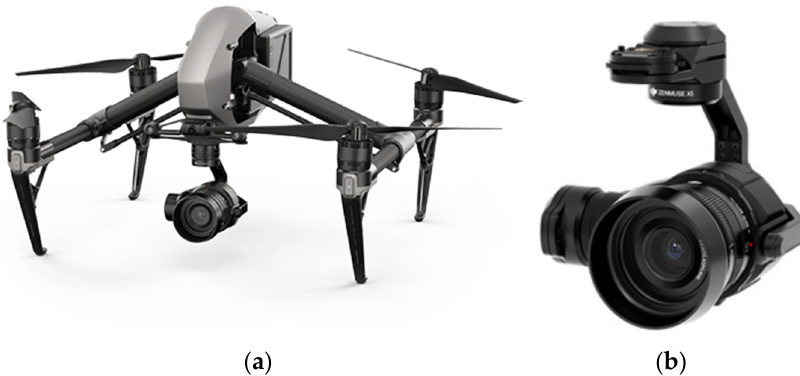
Figure 6. Unmanned aerial photography equipment. ( a ) DJI Inspire 2; ( b ) Zenmuse X5S.